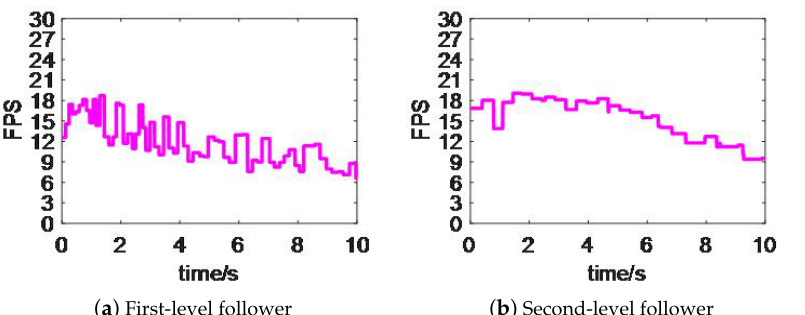
Figure 33. Frame rate measured by the vision of the first-level follower robot and the second-level follower robot over